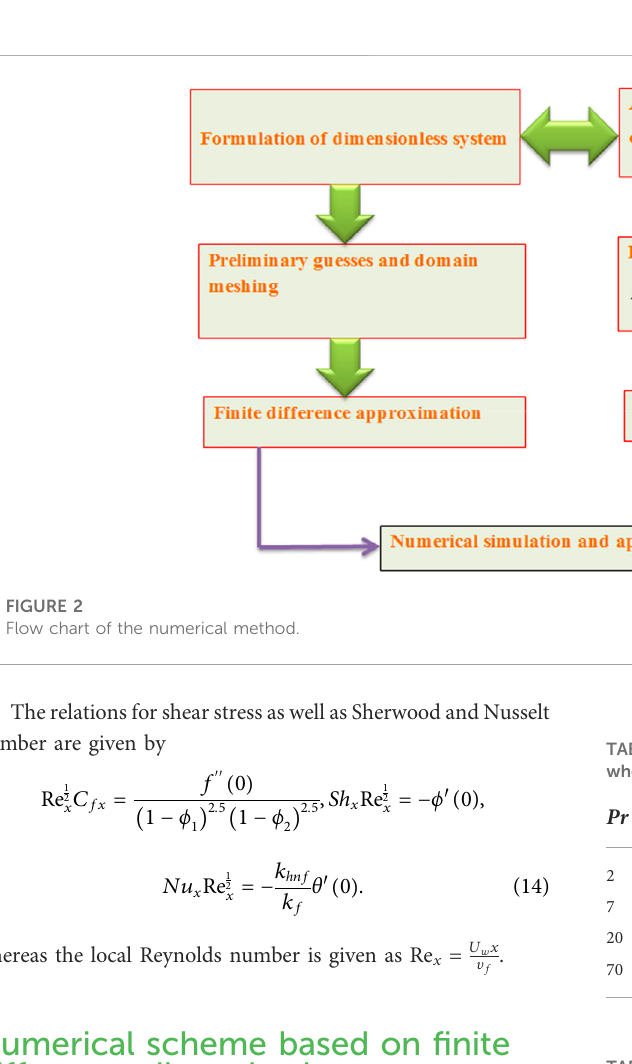
TABLE 3 Impact of porosity parameter on Re 1 / 2 x C f and Re − 1 / 2 x Nu x